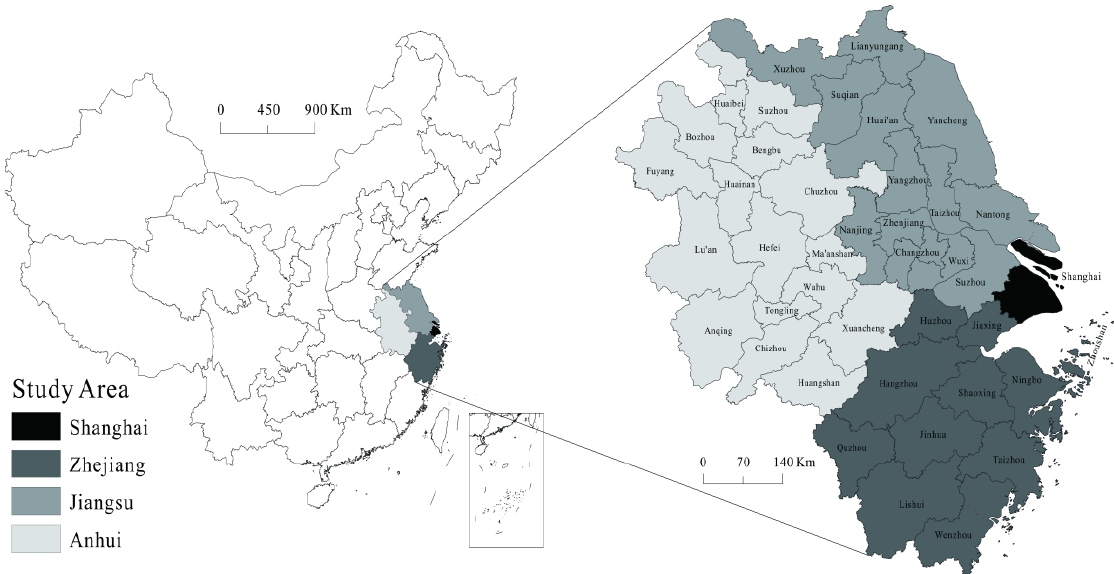
Figure 1. The study